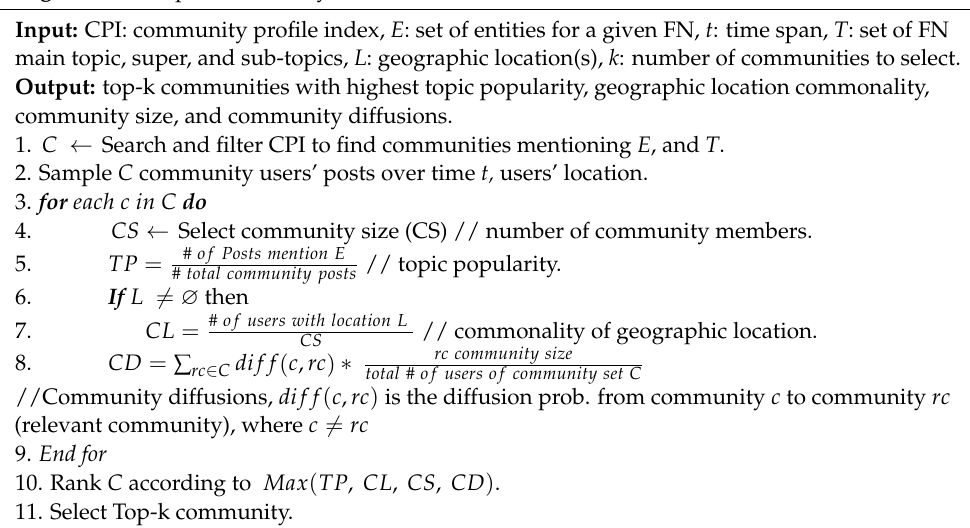
Algorithm 1. Top-k community selection